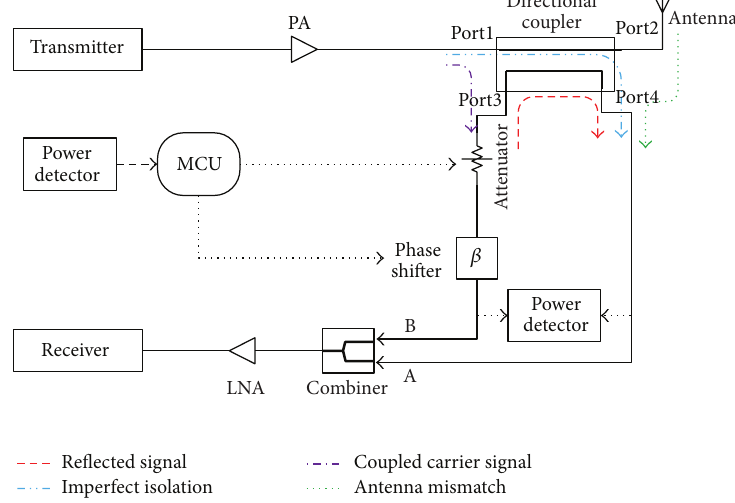
Figure 5: Block diagram of the proposed CLS circuit.